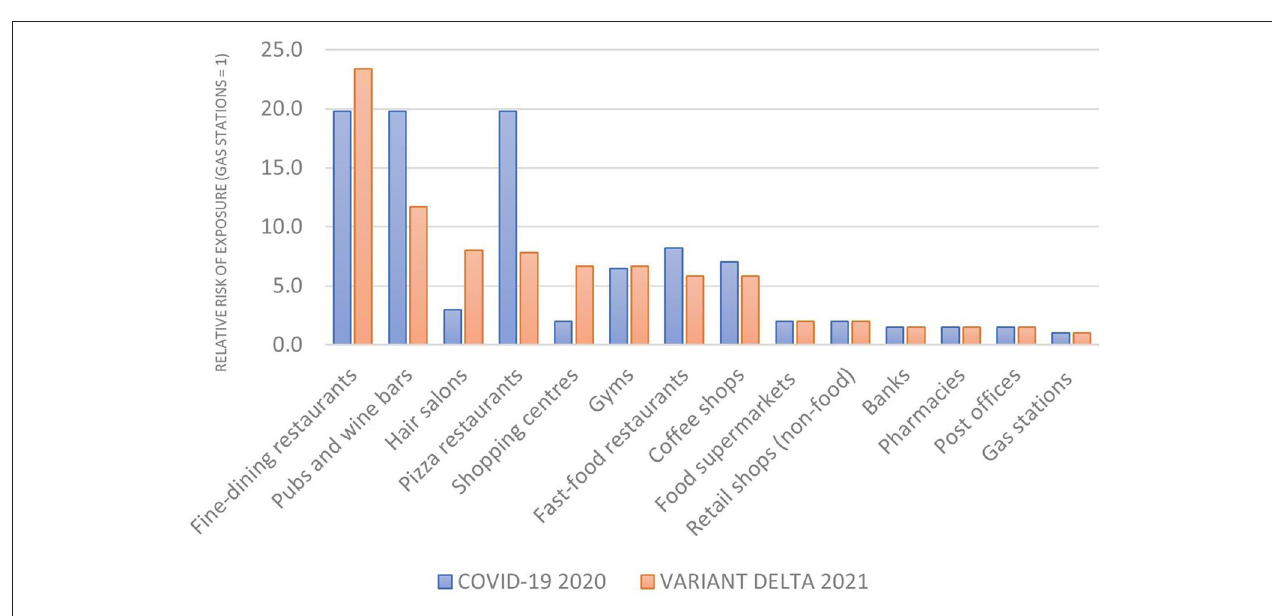
FIGURE 4 | The relative risk of exposure (gas stations =